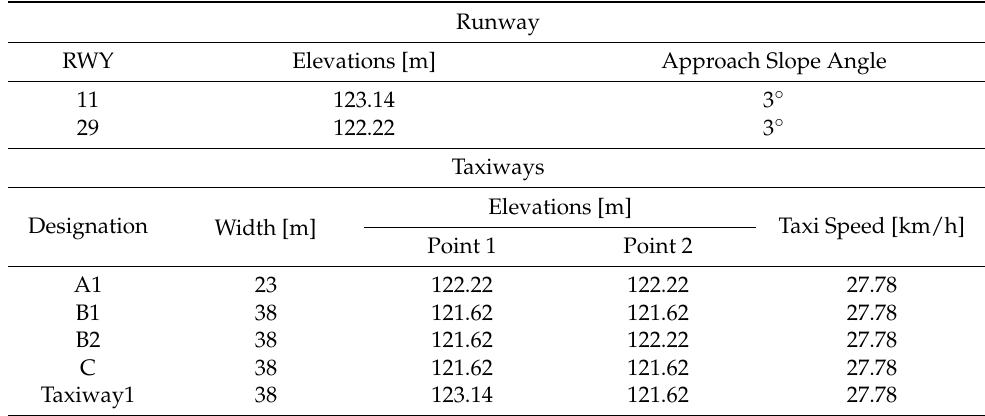
Table 3. Summary of parameters used for runway and